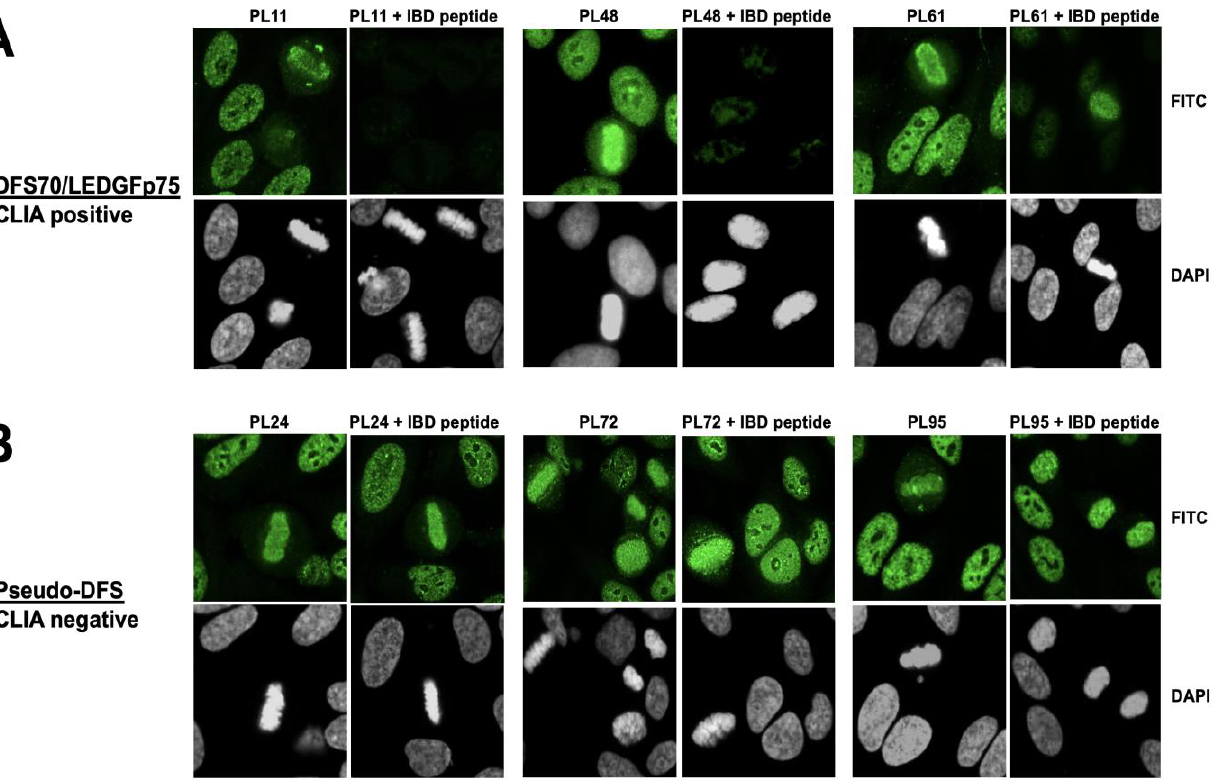
Figure 2. Immunoadsorption of sera with the DFS70/LEDGFp75 integrase binding domain (IBD) autoepitope peptide. ( A ) Pre-absorption of CLIA anti-DFS70-positive sera with the IBD peptide abolished their DFS IFA staining in HEp-2 cells. ( B ) Pre-absorption of CLIA anti-DFS70-negative sera with the IBD peptide failed to abolish their pseudo-DFS IFA staining. Images were obtained by confocal microscopy. Chromatin staining with DAPI is presented in black and white for better visualization.